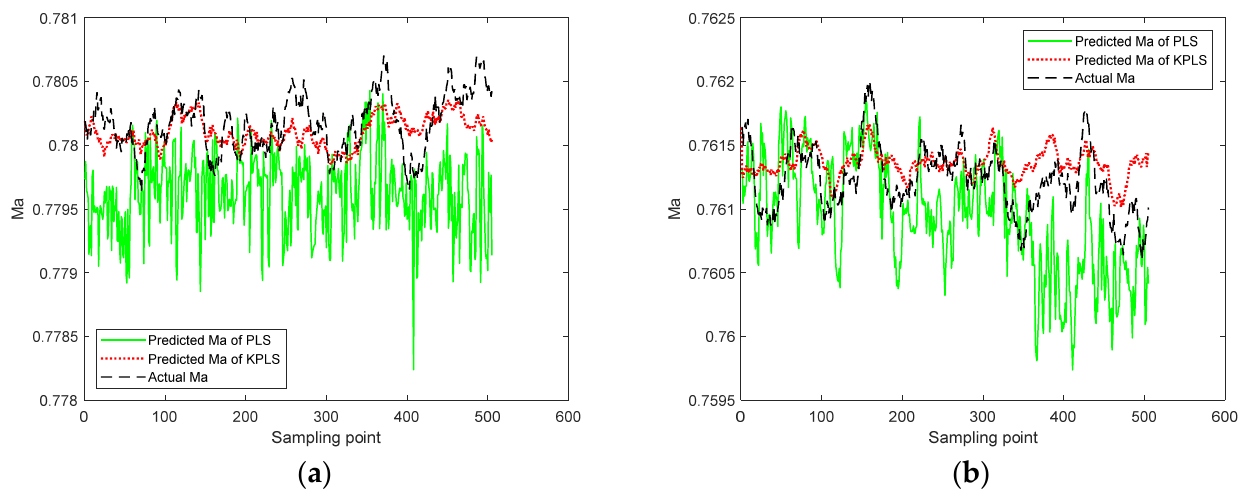
Figure 6. Mach number prediction results of the mean-value PLS and mean-value KPLS models.